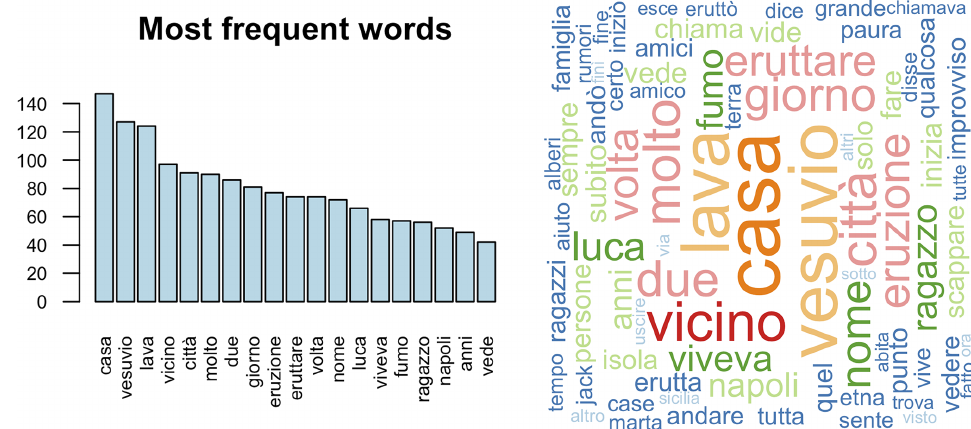
Figure 1. Frequencies of the most used terms in the written descriptions of the imaginary eruption and associated word cloud. The meaning of the terms are as follows: casa (home), Vesuvio (Mount Vesuvius), lava (lava), vicino (nearby), città (city), molto (much), due (two), giorno (day), eruzione (eruption), eruttare (to erupt), volta (time; turns), Luca, viveva (lived), fumo (smoke), ragazzo (boy), Napoli (Naples), anni (years), vede (s/he sees), subito (now), inizia (begins), fare (to do), and vide (s/he saw). Stop words added to the original list and not included in the count are: perché (why), così (therefore), poi (after), allora (then), cosa (what; thing), quindi (therefore), però (however), po’ (a bit), dopo (after), mentre (meanwhile), lì (there), and quando (when).